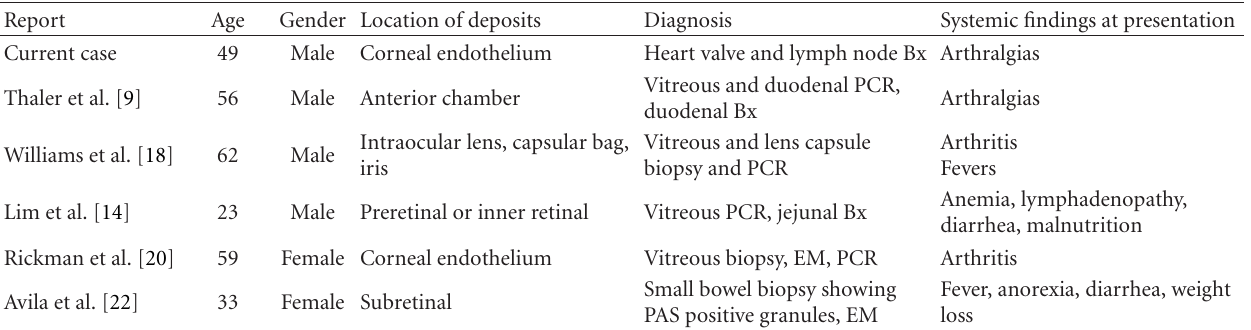
Bx: biopsy; PCR: polymerase chain reaction; EM: electron microscopy; PAS: periodic acid-Schi ff